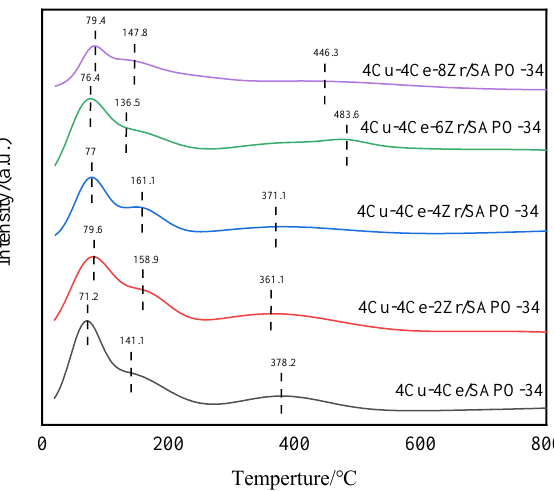
Figure 2. XRD spectra of catalysts with different Zr loadings.